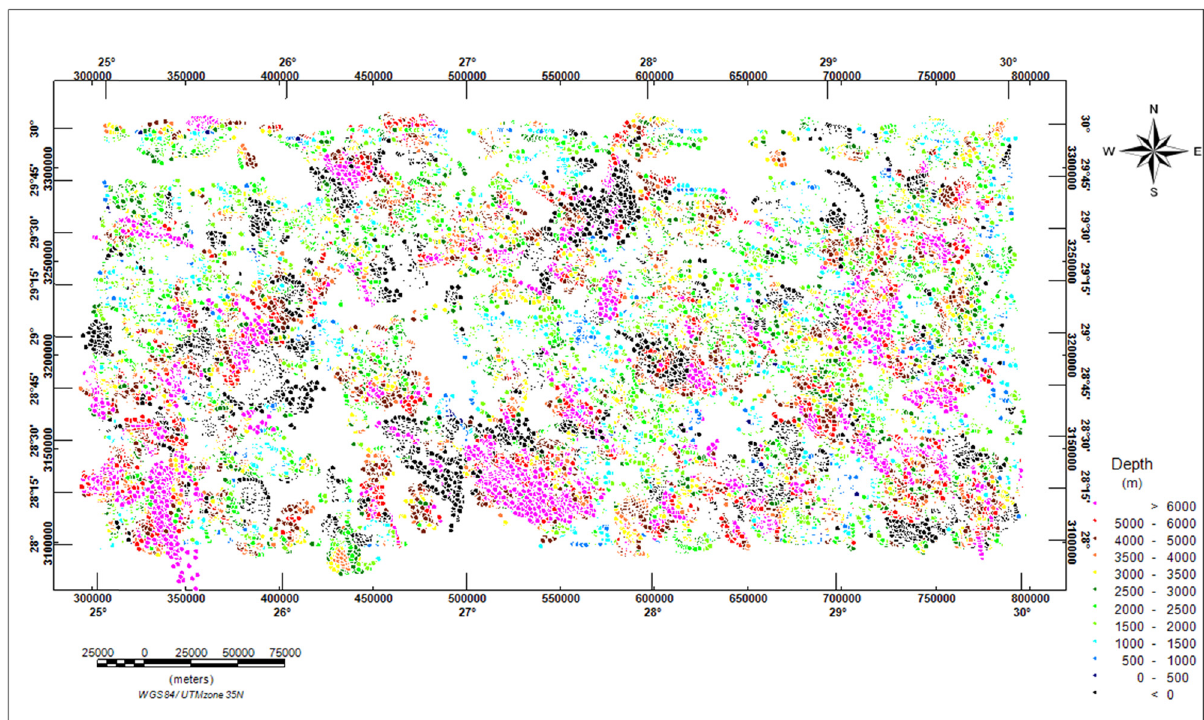
Figure 8: Euler solutions of structural index =